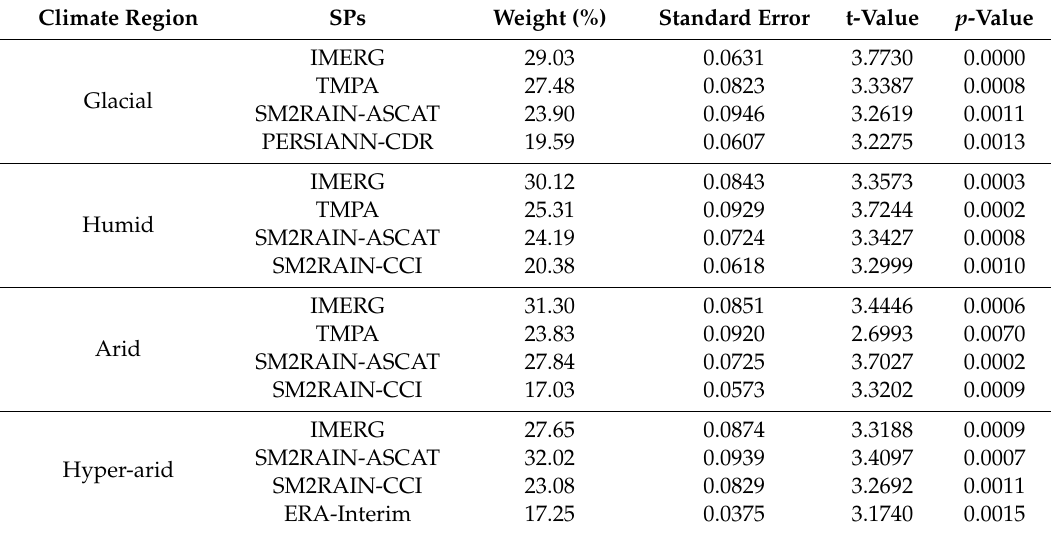
Table 5. Average blending weights, standard error, t-values, and p -values of the selected SPDs across all climate